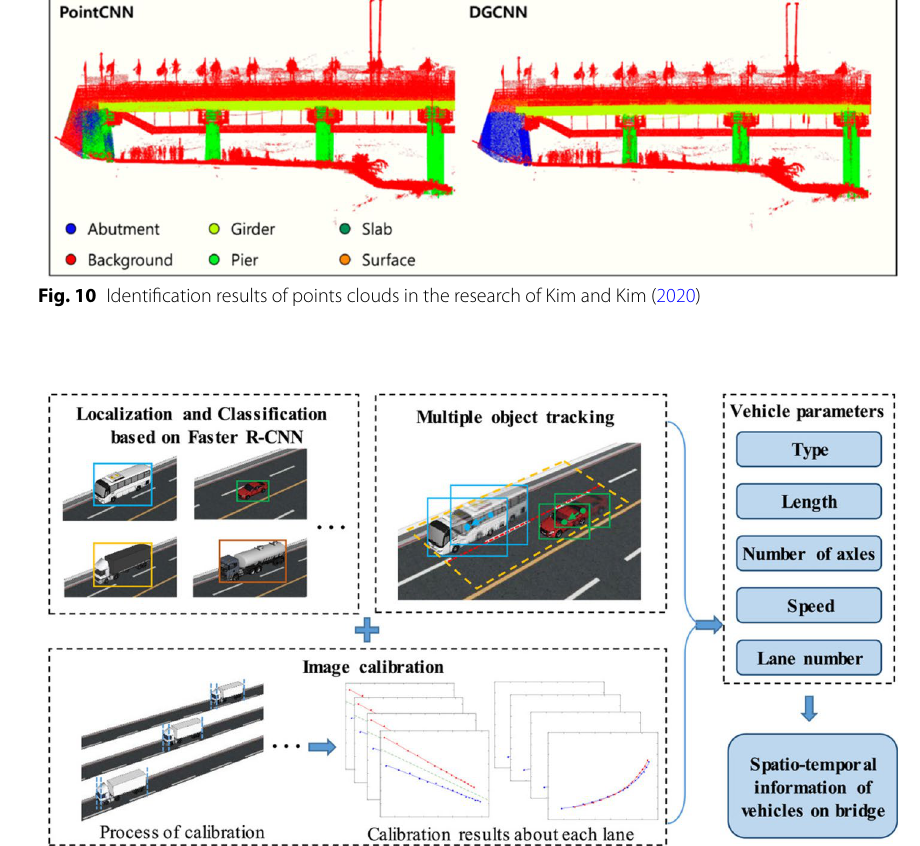
Fig. 11 The framework for obtaining the spatiotemporal information of vehicles by Zhang et al